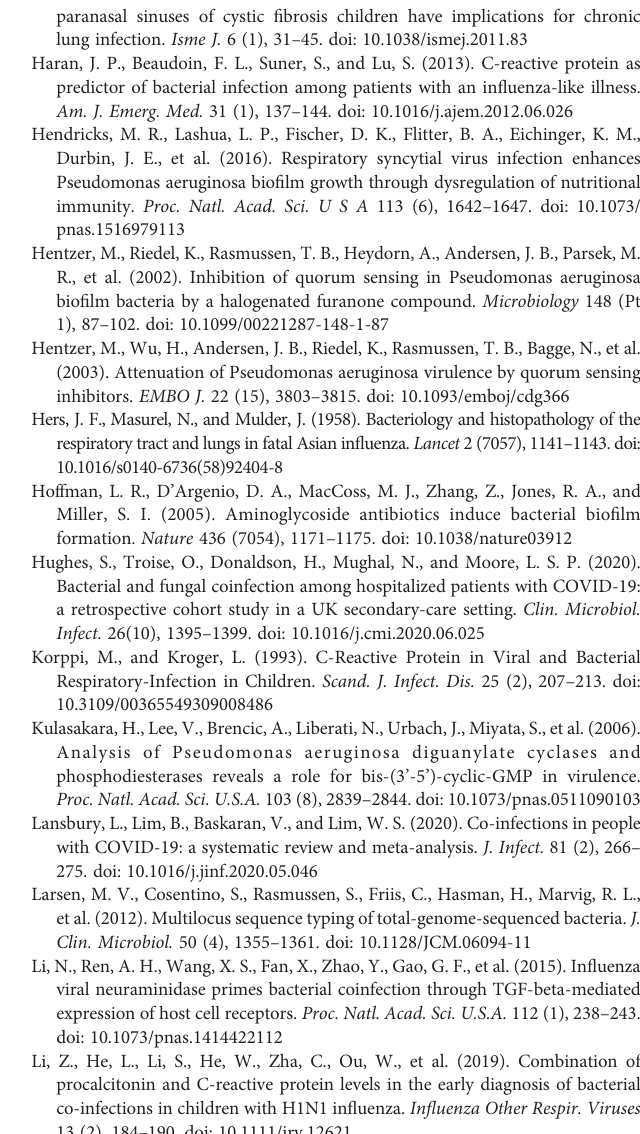
Supplementary Figure 1 | Blood index levels of the other 3 critically illed patients. (A) Blood index levels of patient 2: Upper panel: Counts of WBC, L and N during the course of hospitalization. Red arrows indicate the isolation times of fi rst P. aeruginosa isolate (day 12) and last P. aeruginosa isolate (day 48); Lower panel: Levels of IL-6(pg/mL), CRP (mg/L) and PCT (ng/mL) during the course of hospitalization. Orange arrows indicate the isolation times of fi rst P. aeruginosa isolate (day 12) and last P. aeruginosa isolate (day 48); (B) Blood index levels of patient 3: Upper panel: Counts of WBC, L and N during the course of hospitalization. Red arrows indicate the isolation times of fi rst P. aeruginosa isolate (day 17) and last P. aeruginosa isolate (day 39); Lower panel: Levels of IL-6(pg/mL), CRP (mg/L) and PCT (ng/mL) during the course of hospitalization. Orange arrows indicate the isolation times of fi rst P. aeruginosa isolate (day 17) and last P. aeruginosa isolate (day 39); (C) Blood index levels of patient 4: Upper panel: Counts of WBC, L and N during the course of hospitalization. Red arrows indicate the isolation times of fi rst P. aeruginosa isolate (day 31) and last P. aeruginosa isolate (day 43); Lower panel: Levels of IL-6(pg/mL), CRP (mg/L) and PCT (ng/mL) during the course of hospitalization. Orange arrows indicate the isolation times of fi rst P. aeruginosa isolate (day 31) and last P. aeruginosa isolate (day 43).